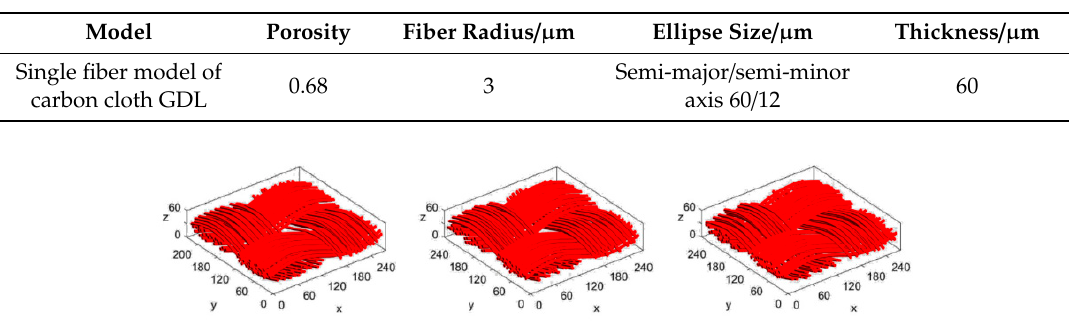
Table 1. Input parameters of stochastically reconstructed carbon cloth model.